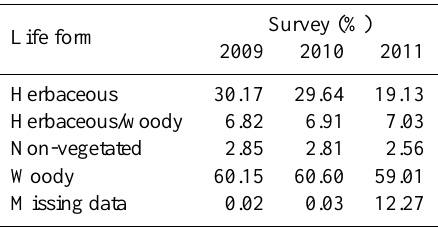
Table 5. Proportions of crop types defined according to the FAO- LCCS crop types. Note that the survey data of 2011 are